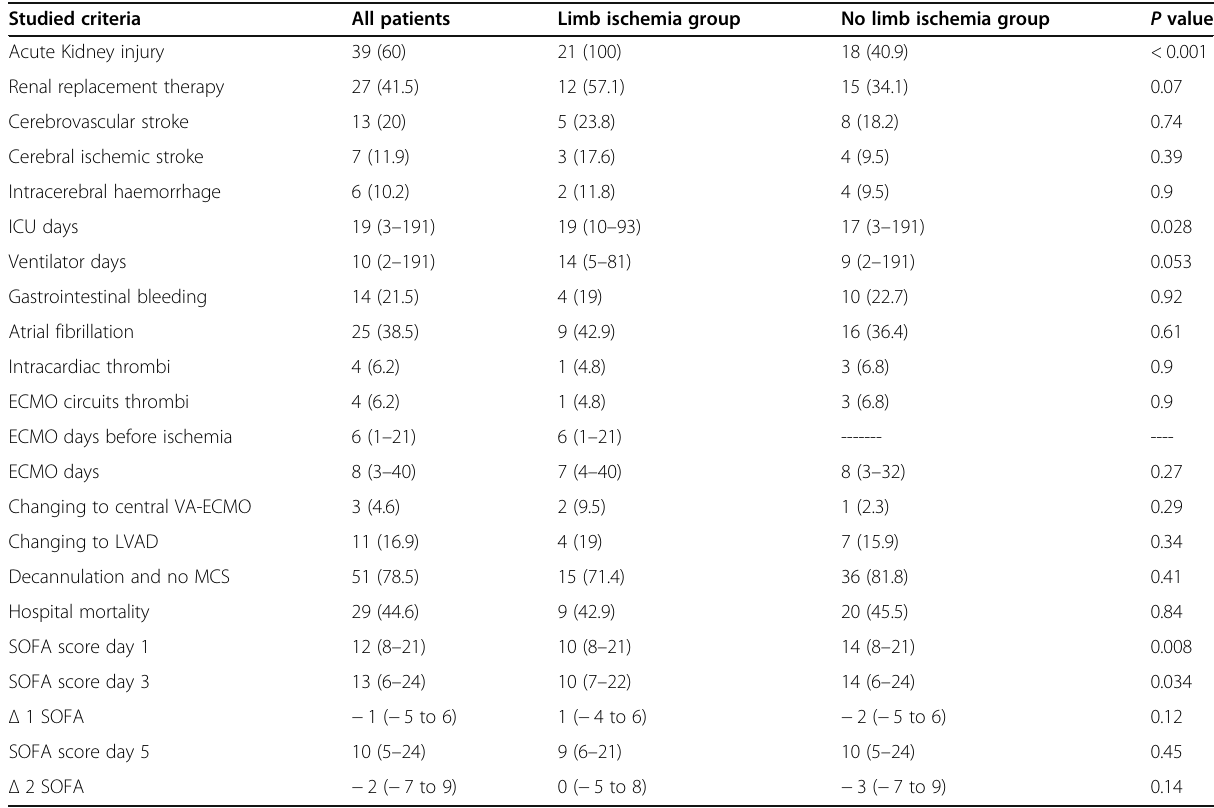
Table 4 Hospital course of the studied VA-ECMO-treated patients Studied